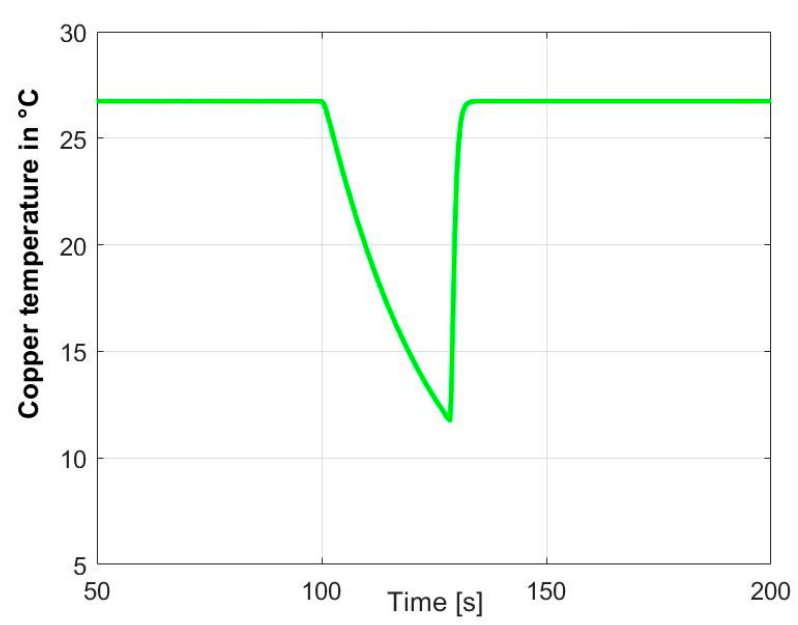
Figure 10. Diagram of copper temperature in function of time for a number of sections n = 5.